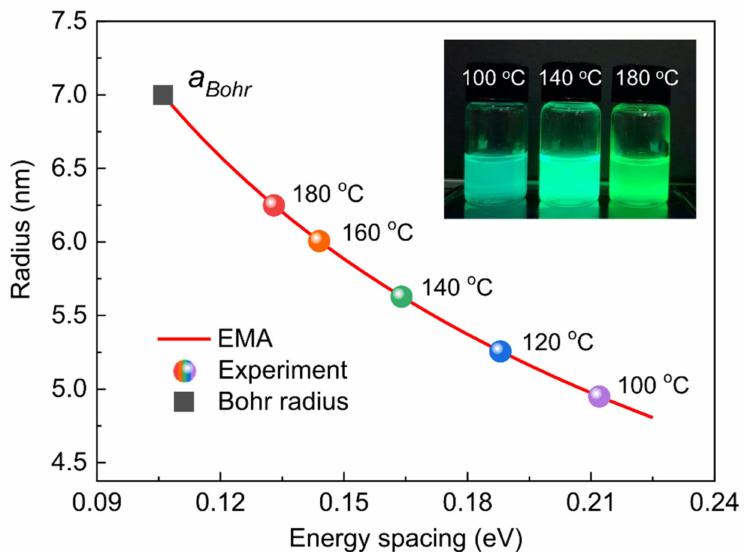
Figure 4. Calculated radius for CsPbBr 3 perovskite NCs as a function of the energy spacing. The experimental data are plotted with symbols and the solid line represents theoretical prediction (effective mass approximation, EMA).